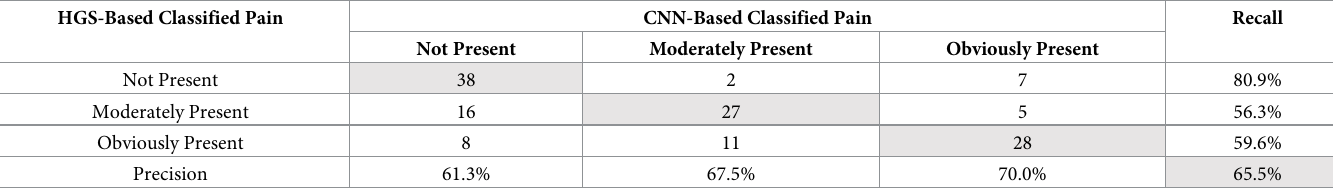
Table 5. Confusion matrix between the data classified by the CNN-based model and HGS for the eyes images. HGS-Based Classified